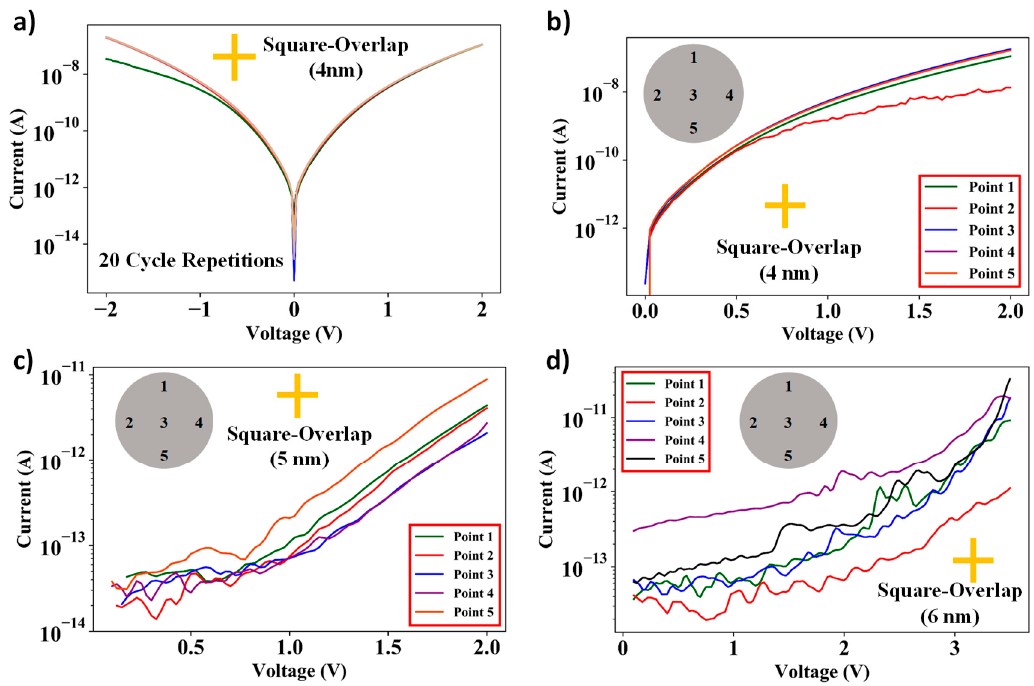
Figure 10. Plots for (a) 20 cycles of repetitive I–V measurements of square ‐ overlap layout devices having spacer thickness of 4nm, and I–V measurements of square ‐ overlap devices over five different areas on a 4 ‐ inch Si wafer having spacer layer thicknesses of (b) 4 nm, (c) 5 nm, and (d) 6